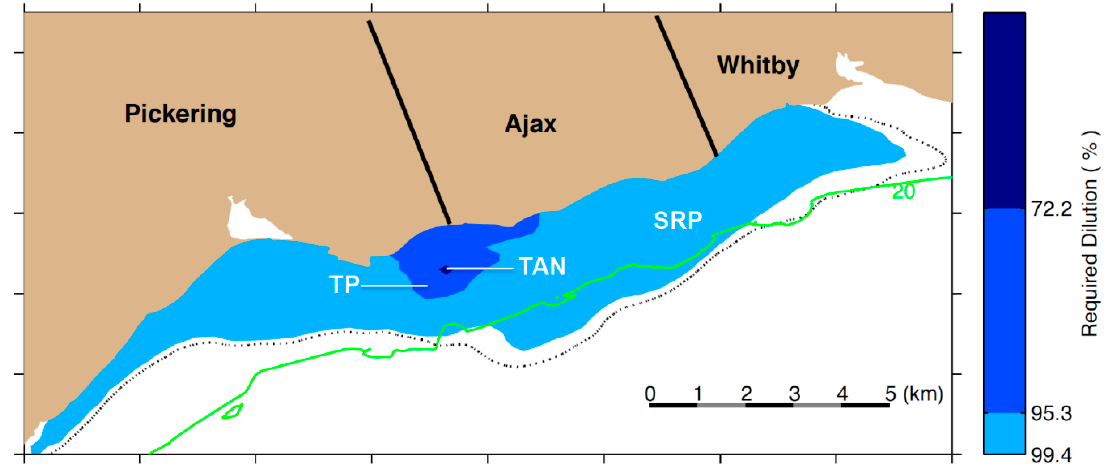
Figure 12. Model-predicted conservative tracer footprints for three pollutants of concern discharged by the Duffin Creek WWTP. Results are water column averages for a seven-day (13–19 July 2014) continuous discharge. The dashed black line identifies the extent of the effluent plume, defined here as a 99.5% reduction from the effluent concentration. Footprint boundaries, corresponding to pollutant of concern (POC)-specific D values (Table 3), circumscribe the area where in-lake POC concentrations exceed the water quality standard. The green line is the 20-m depth representing the lakeward extent of colonization by Cladophora [24] and approximating the accepted separation of nearshore and offshore waters [5,6,22]. Model results are from run#2.